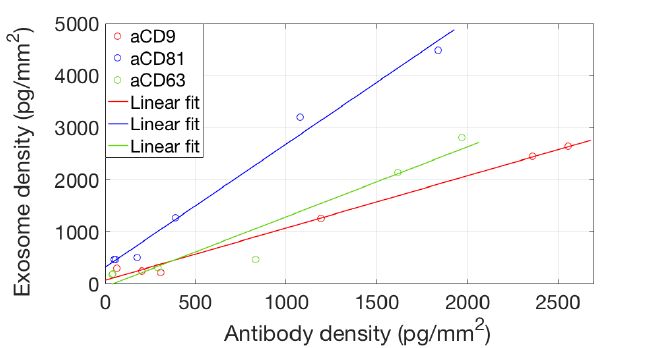
Figure 7. Correlation between the amount of active antibody immobilized on the surface and the total amount of captured EVs. The x coordinate of the data points corresponds to the maximum binding signal reached in Figure 4, while the y coordinate is the maximum EVs binding signal as shown in Figure 6. A linear correlation of the two datasets (no saturation) implies that—for this concentration range—the avidity regime does not